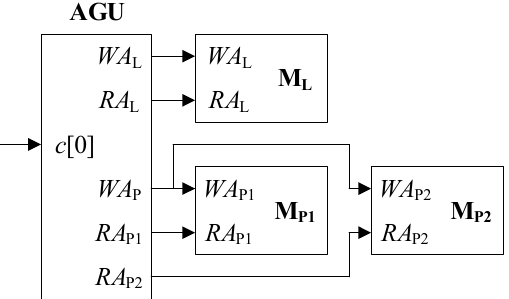
Figure 2. Interface between address generation unit (AGU) and memories.